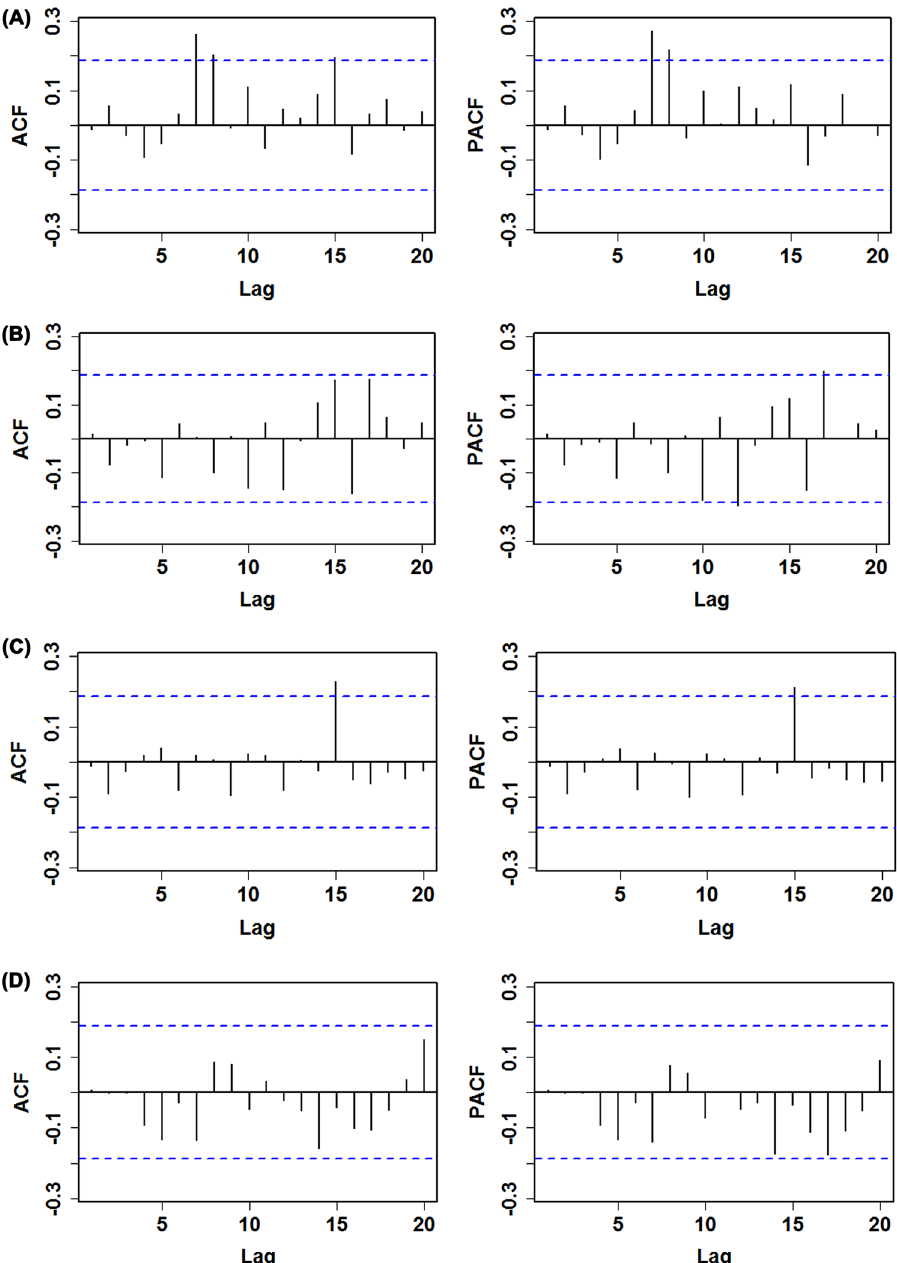
Figure 3. Autocorrelogram (ACF) and partial autocorrelogram (PACF) of the residuals generated by the best ARIMA model. ( A ) Sample ACFs and PACFs of the residuals for the prevalence dada in SouthAfrica; ( B ) Sample ACFs and PACFs of the residuals for the mortality dada in South Africa; ( C ) Sample ACFs and PACFs of the residuals for the prevalence dada in Nigeria; ( D ) Sample ACFs and PACFs of the residuals for the mortality dada in Nigeria. As shown, almost all sample ACFs and PACFs fell within the estimated 95% uncertainty levels across different lags except for the sample ACFs at lags 7, 8, and 15, along with the sample PACFs at lags 7 and 8 in ( A), the sample PACFs at lags 12 and 17 in ( B), and the sample ACFs and PACFs lag 15 in ( C) (which are also reasonable because some higher-order correlation coefficients readily exceed the estimated 95% uncertainty levels by chance). These results meant that the residuals from identified ARIMA models for different datasets were without pattern, suggesting that the selected ARIMA models appear to be suitable for capturing the dynamic dependency structure in the object